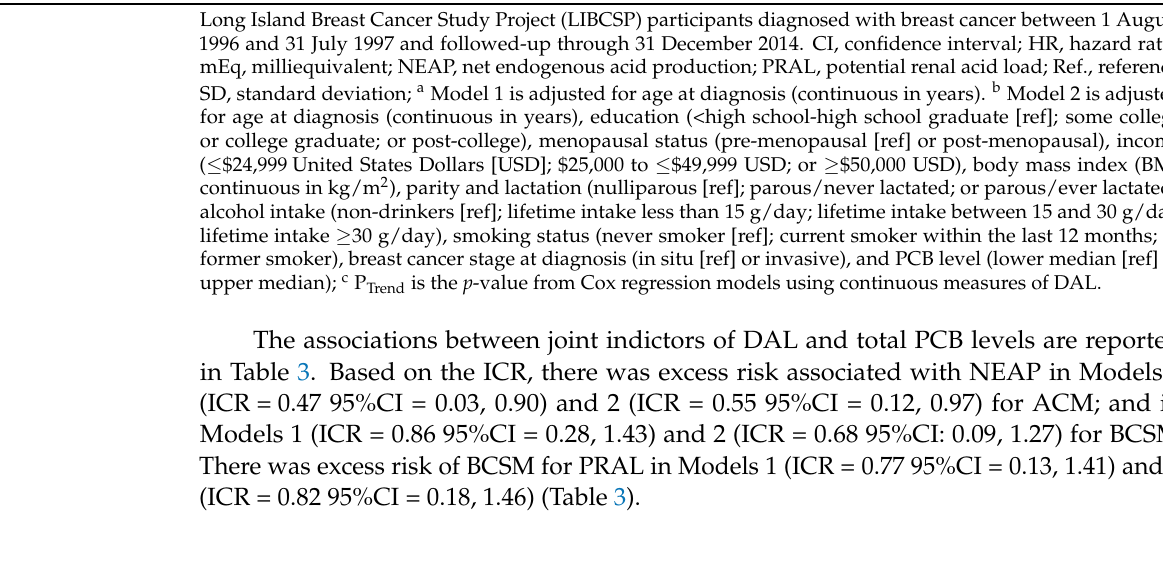
Long Island Breast Cancer Study Project (LIBCSP) participants diagnosed with breast cancer between 1 August 1996 and 31 July 1997 and followed-up through 31 December 2014. CI, confidence interval; HR, hazard ratio; mEq, milliequivalent; NEAP, net endogenous acid production; PRAL, potential renal acid load; Ref., reference; SD, standard deviation; a Model 1 is adjusted for age at diagnosis (continuous in years). b Model 2 is adjusted for age at diagnosis (continuous in years), education (<high school-high school graduate [ref]; some